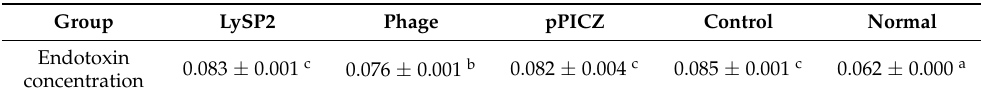
Table 3. Endotoxin detection.